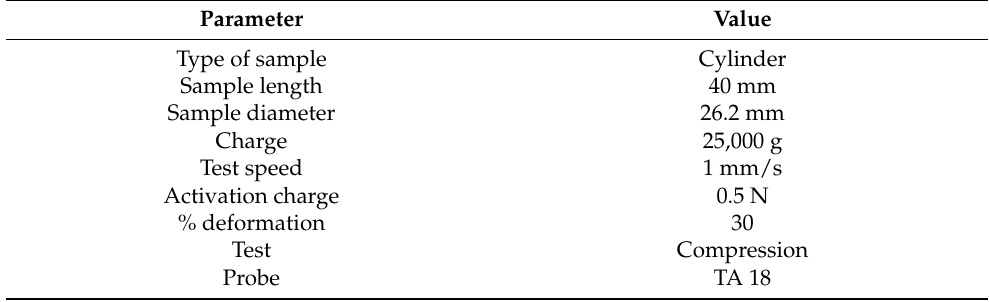
Table 1. Operating conditions used with the Brookfield texture analyzer,